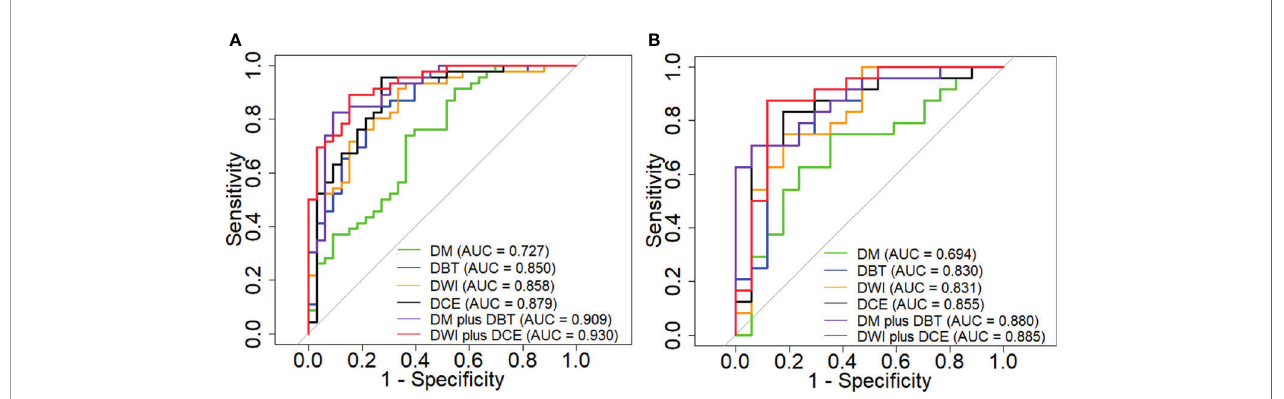
FIGURE 1 | ROC curves of the DM, DBT, DCE MRI and DWI MRI used individually and in comibination in the training (A) and validation (B) cohort.